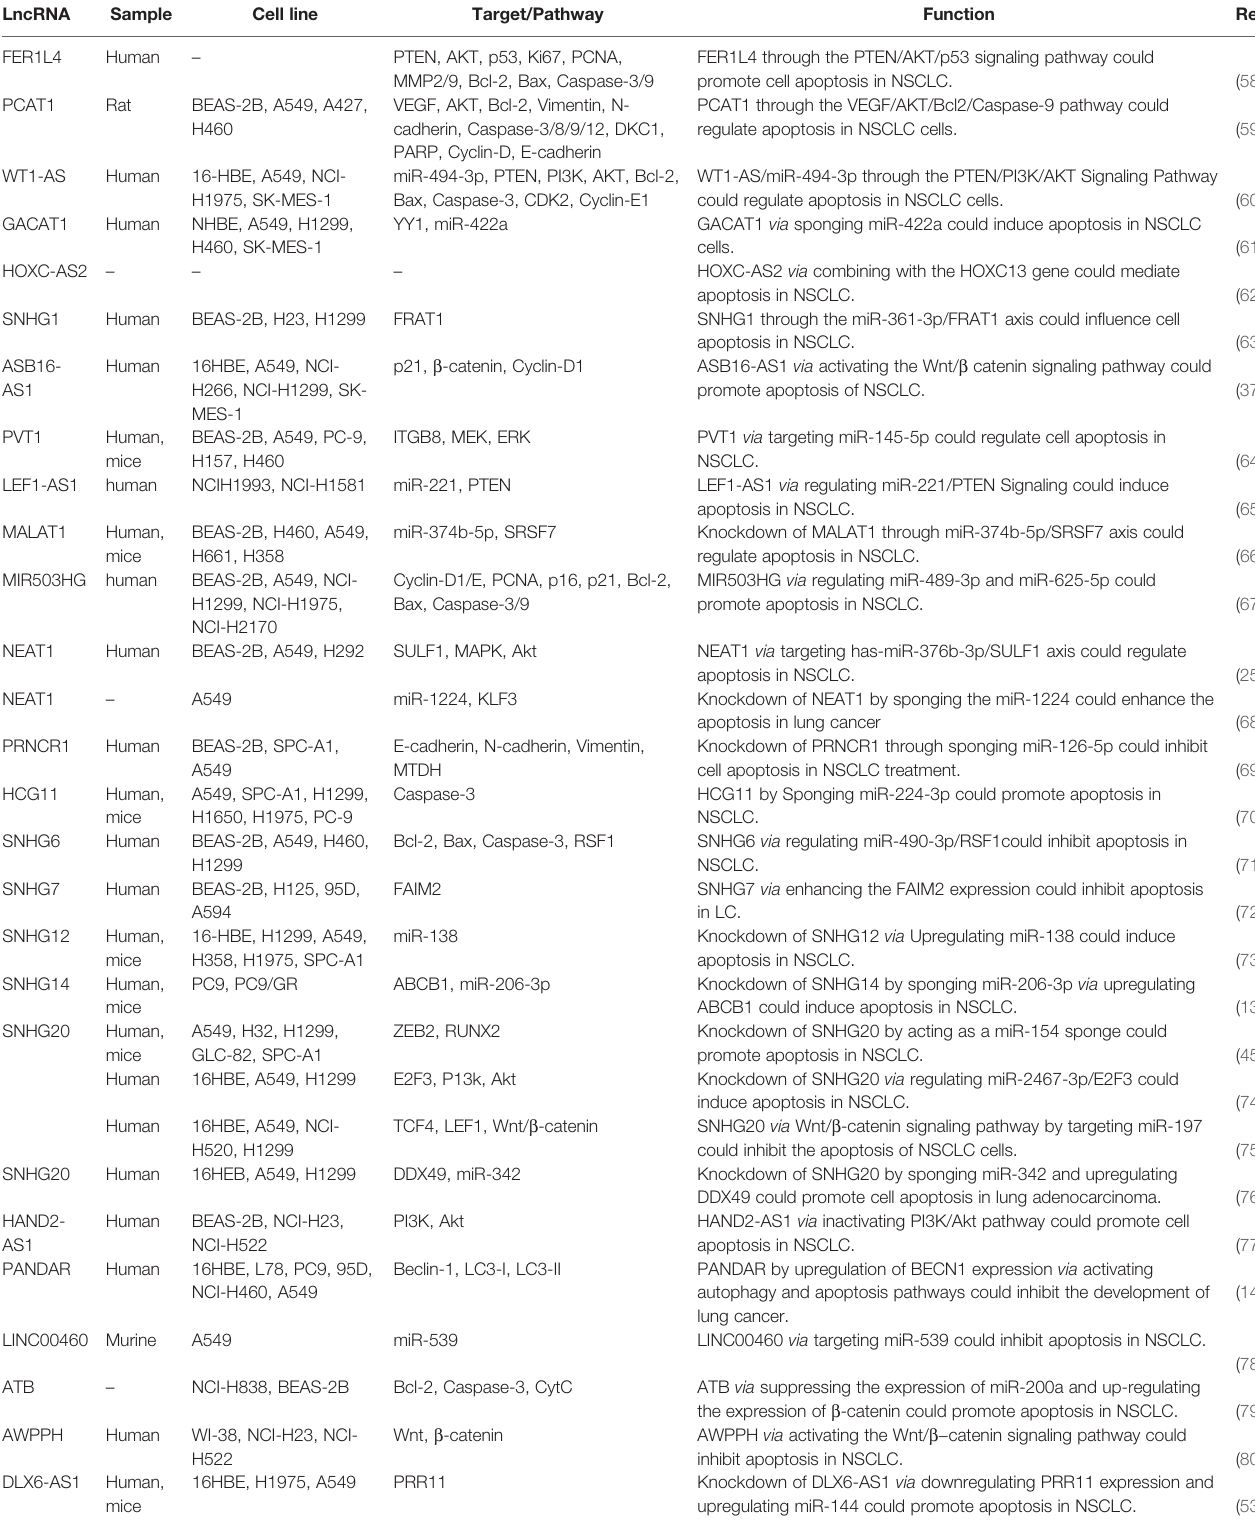
TABLE 2 | LncRNAs regulating apoptosis in lung cancer.